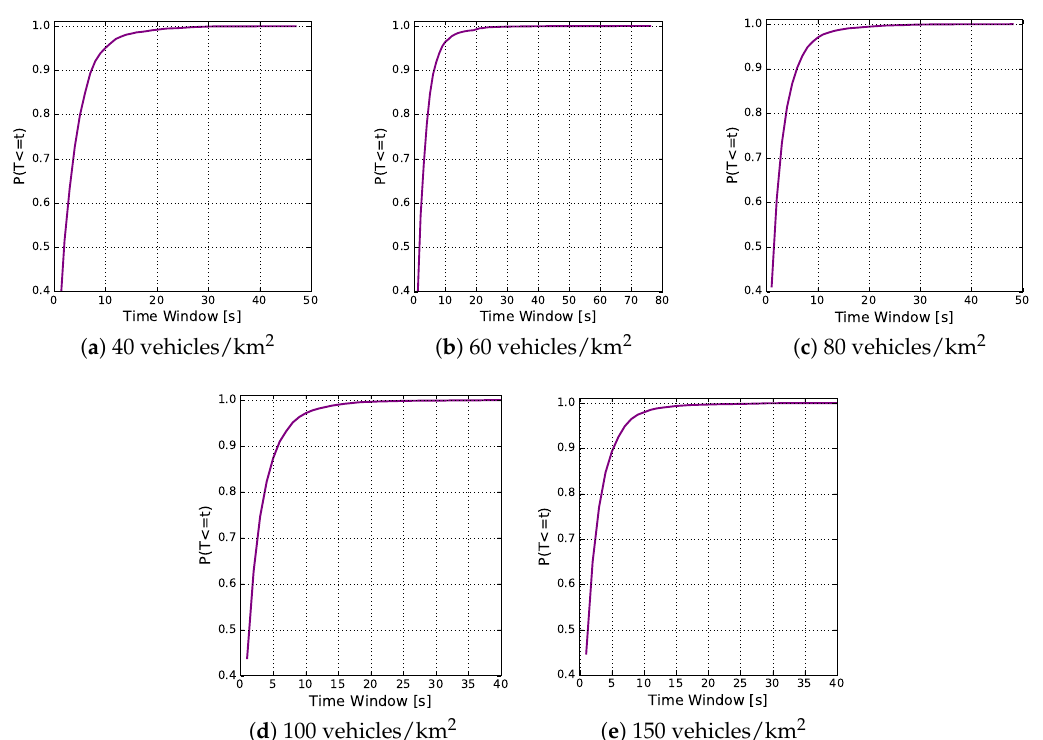
Figure 11. CDF of the time window duration in which there were no changes to the egocentric betweenness score in relation to the vehicle traffic densities.